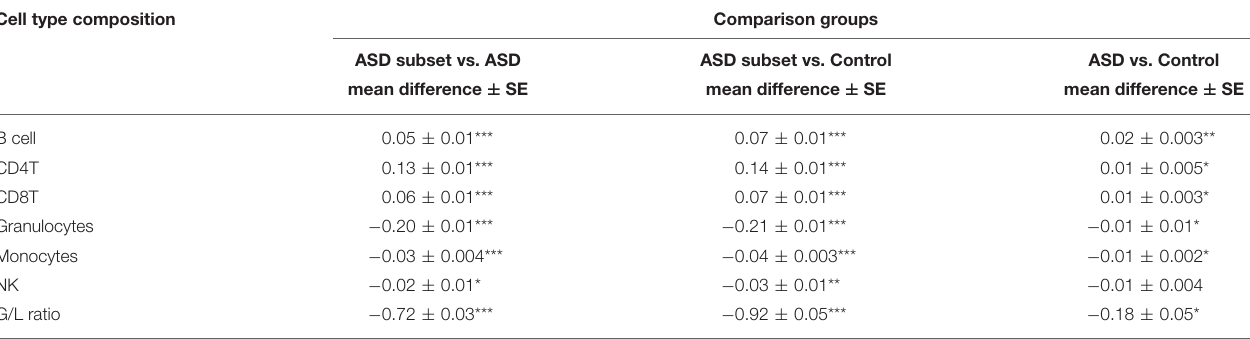
TABLE 3 | Immune blood cell composition comparisons between sample groups: the epigenetically unique ASD subset ( n = 32), the remaining ASD cases ( n = 233), and controls ( n = 122). Cell type composition Comparison